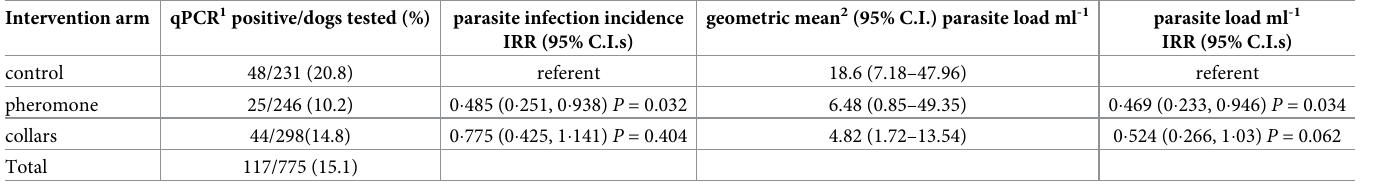
Table 4. Confirmed Leishmania infection incidence, tissue parasite loads, and intervention effects in recruited dogs at